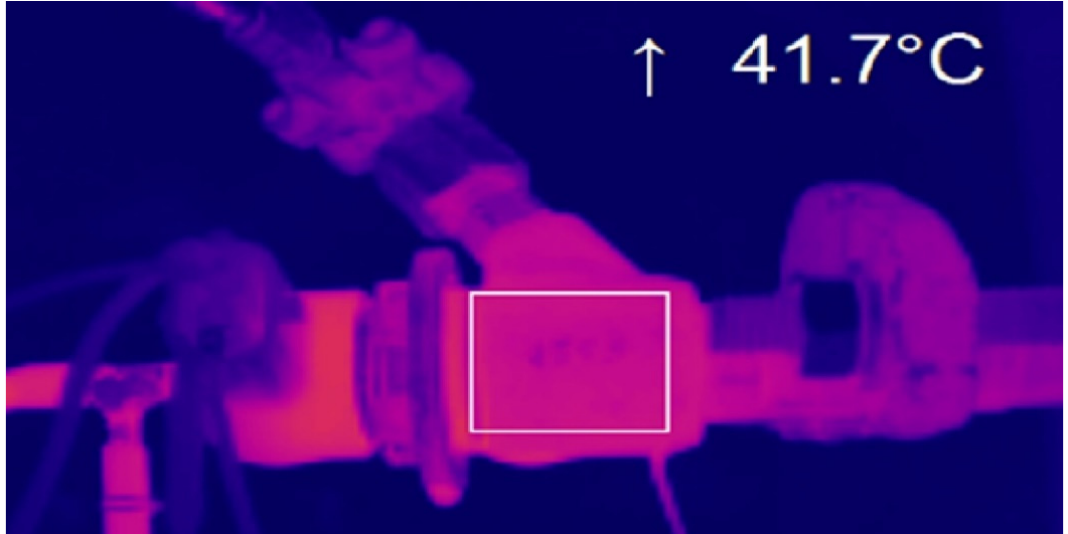
Figure 2. Image of injector frame taken with thermographic camera during a heating process—the rectangle indicates the area of temperature monitoring. The temperature given in the figure refers to its maximum value in area marked with a white rectangle [53].